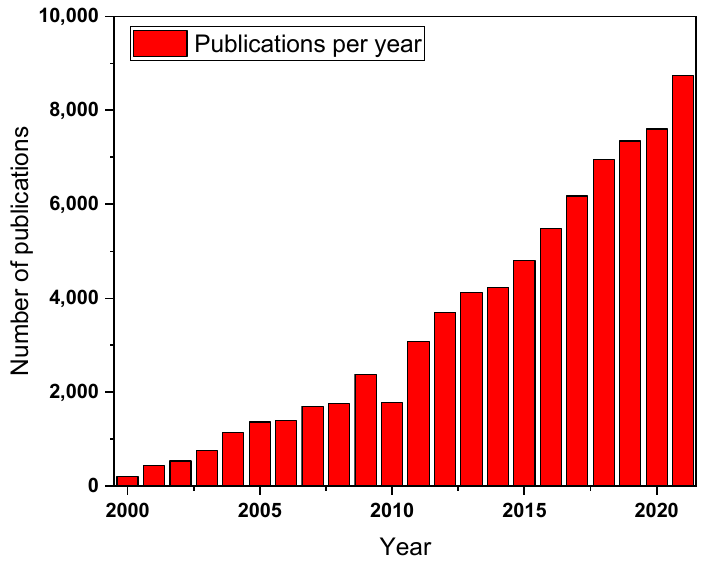
Figure 2. Representative scheme of the publication rate of papers regarding photocatalysis.